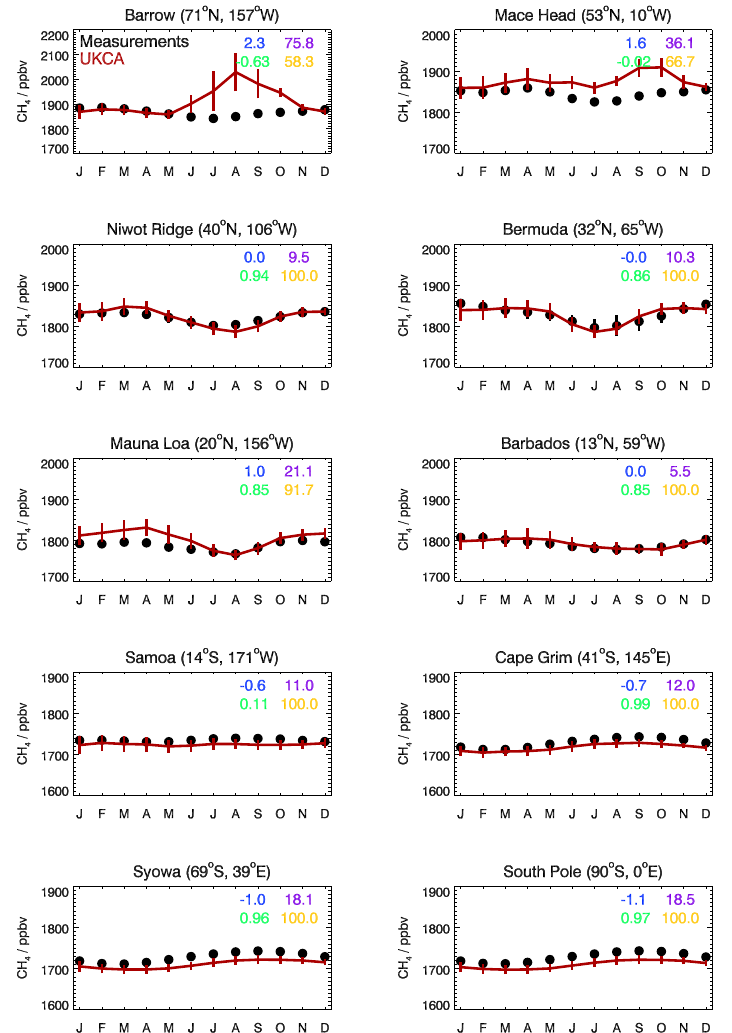
Fig. 13. Comparison between multi-annual monthly mean modelled surface CH 4 concentrations with surface observations from the 1999– 2006 time period. The surface sites include Barrow (71 ◦ N, 157 ◦ W), Mace Head (53 ◦ N, 10 ◦ W), Niwot Ridge (40 ◦ N, 106 ◦ W), Bermuda (32 ◦ N, 65 ◦ W), Mauna Loa (20 ◦ N, 156 ◦ W), Barbados (13 ◦ N, 59 ◦ W), Samoa (14 ◦ S, 171 ◦ W), Cape Grim (41 ◦ S, 145 ◦ E), Syowa (69 ◦ S, 39 ◦ E), and the South Pole (90 ◦ S, 0 ◦ E). The relative annual mean bias (in %), the root mean square error (in pbbv), the correlation coefficient, and the model score (the percentage of months where the modelled and observed monthly mean concentrations are within 2% of each other; in %) are shown for each location in blue, purple, green, and orange, respectively.